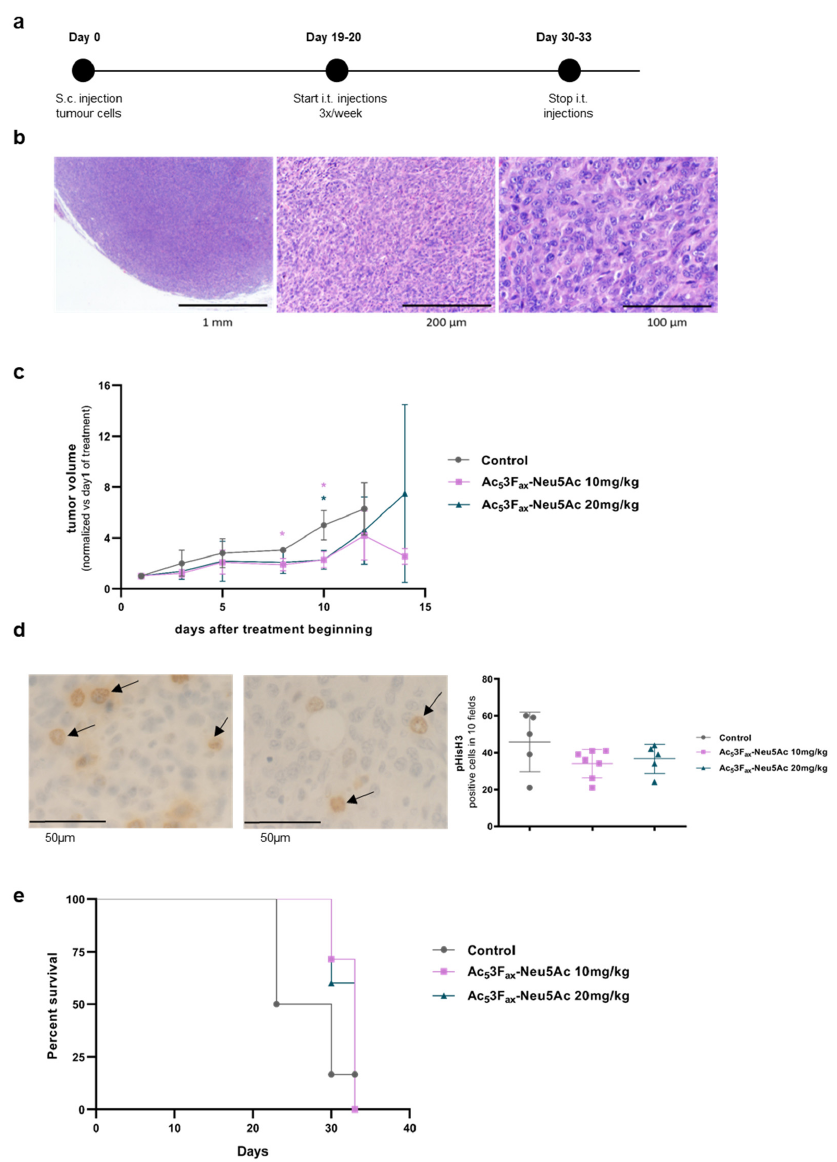
Figure 5. Effect of intratumoral Ac 5 3F ax Neu5Ac injections in tumor growth. KC cells were subcutaneously inoculated and tumors were treated with PBS, DMSO, or 10 mg/kg or 20 mg/kg Ac 5 3F ax Neu5Ac. ( a ) Time-based diagram of the experiment; ( b ) Haematoxylin-eosin staining of a representative tumor at different magnification (20×, 63× and 200×); ( c ) Tumor volume was measured thrice per week by measuring the three perpendicular diameters with a vernier caliper, since the beginning of the tumor treatment. Tumor volumes are represented as mean values of each group ± SD, and normalized vs their tumor volume at the first day of administration. * p < 0.01.; ( d ) IHC with anti- pHisH3 of a representative PBS-treated control tumor (left) and 10 mg/kg Ac 5 3F ax Neu5Ac-treated tumor (right) at 400× (arrows indicate stained cells), and graph of the quantification of pHisH3 cell staining of tumors ( e ) Kaplan–Meier curve corresponding to mice survival of each mice group are represented.